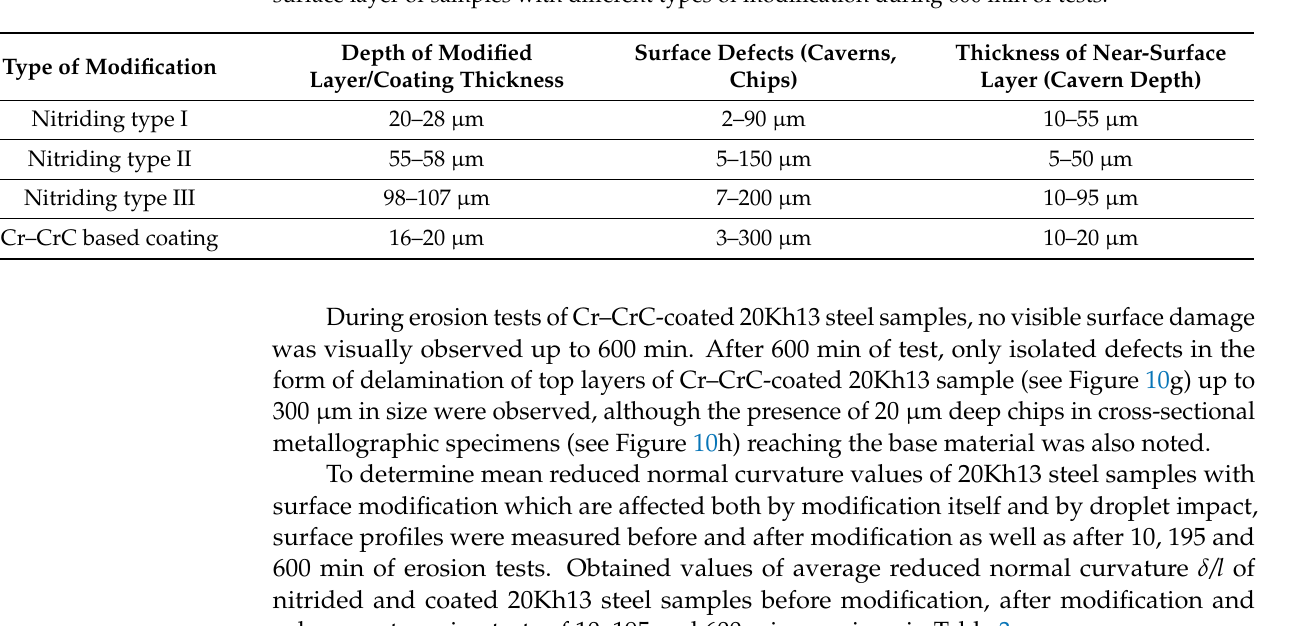
Table 2. Results of visual analysis and microscopic examination of damages of surface and near- surface layer of samples with different types of modification during 600 min of tests.